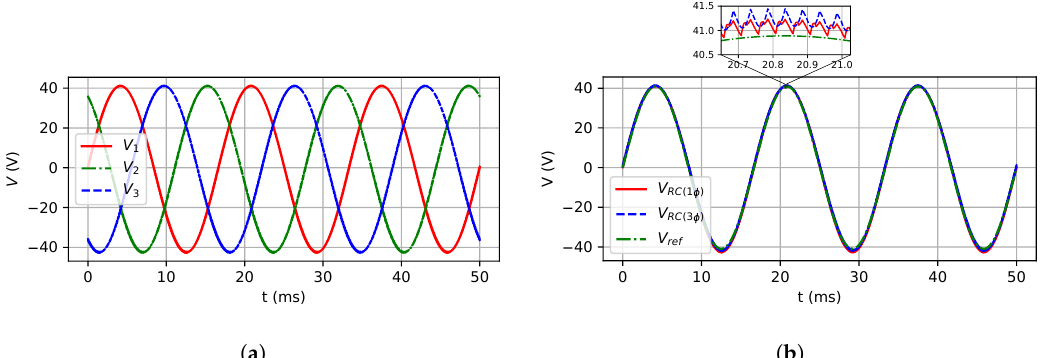
Figure 20. Load phase for RC load case: ( a ) Three-phase model; ( b ) Single-phase and three-phase (leg 1)